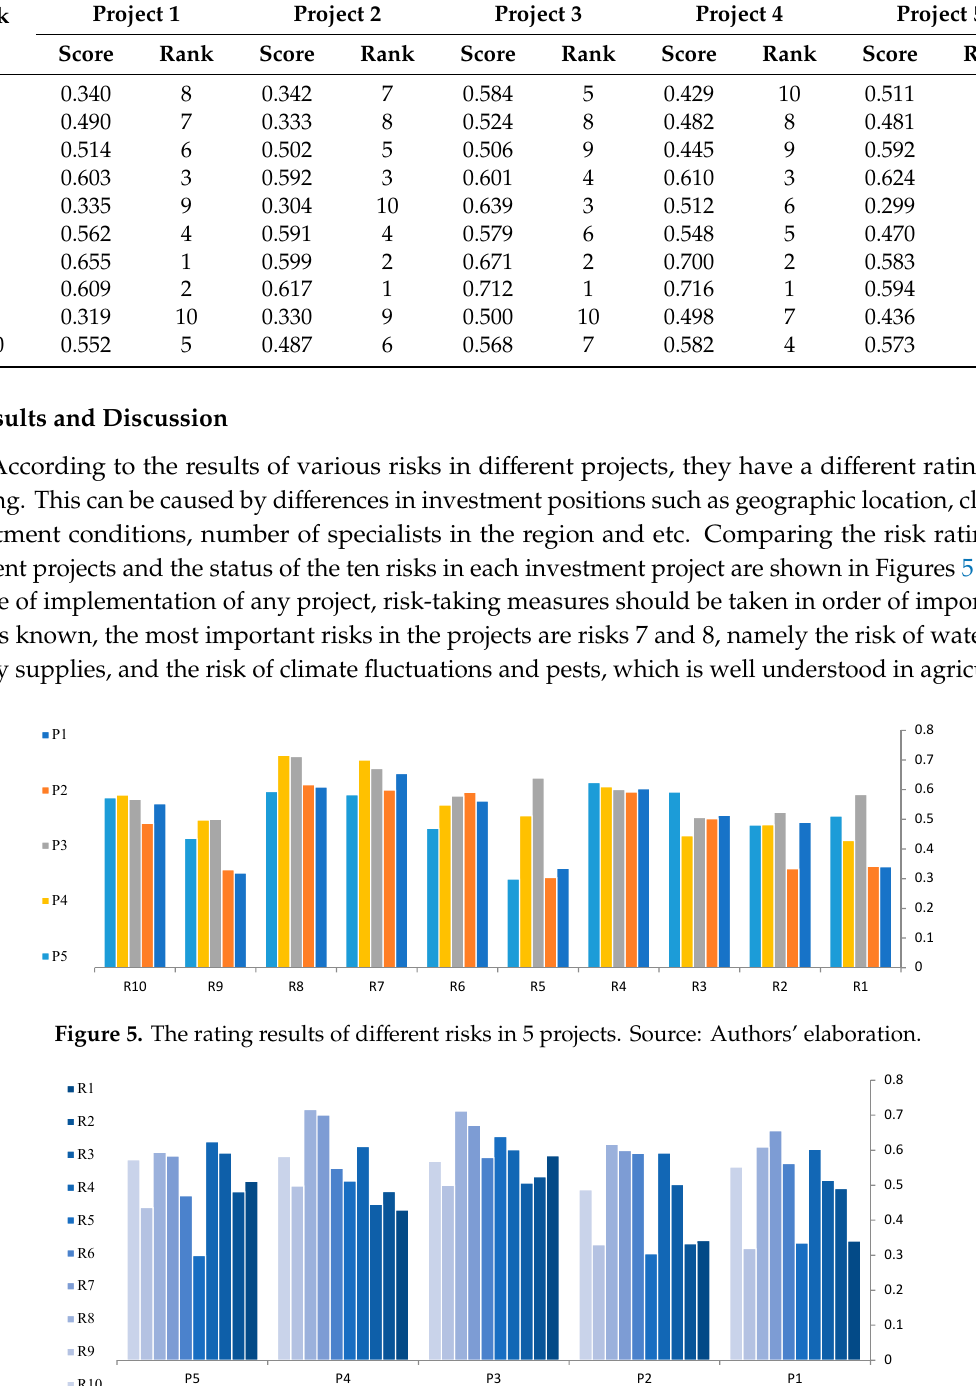
Figure 6. The status of 10 different risks in each investment project .